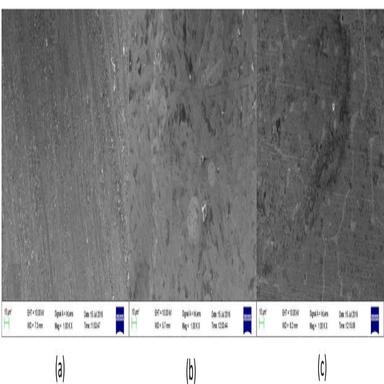
FESEM image of Sample-Al + SiC (a) 1%, (b) 1.5% and 2%.